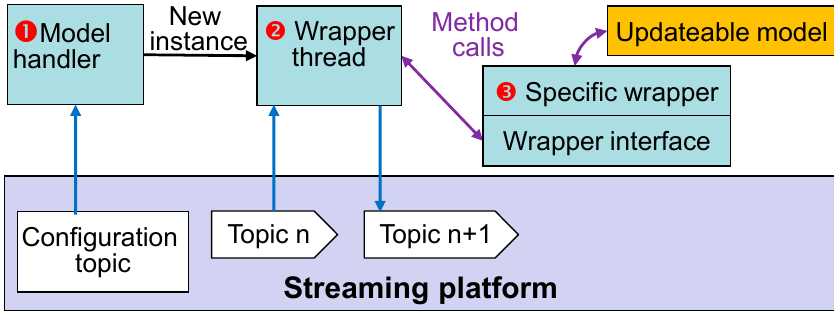
Figure 6. General wrapper software structure.